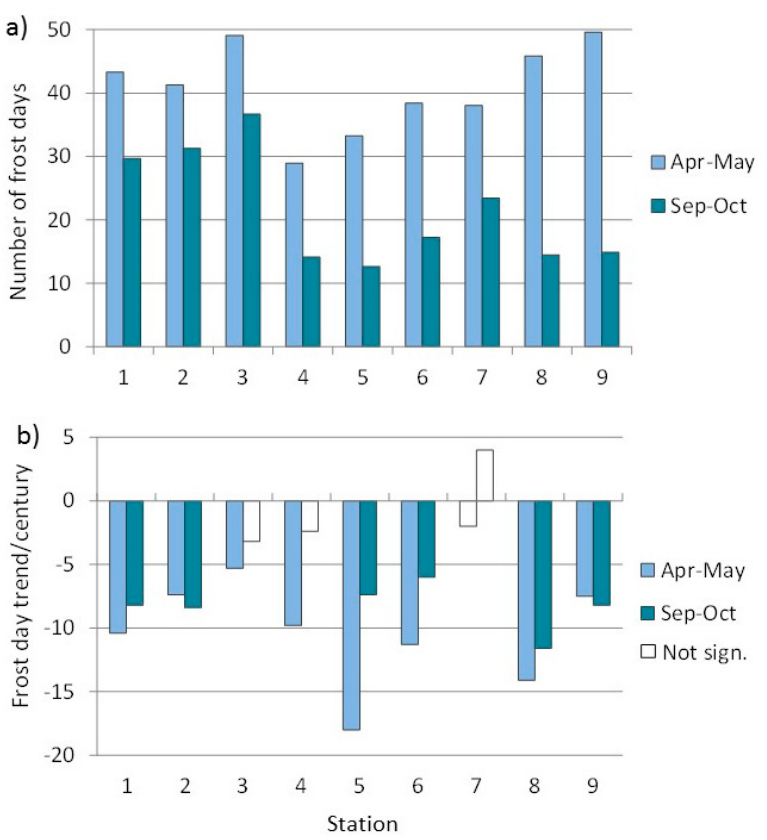
Figure 2. (a) The average number of frost days (TMin < 0°C) and ( b ) a frost day trend (change in the number of frost days/100 years) in April-May and September-October in nine studied weather station. Stations 1, 6, and 9 are homogeneous, and only isolated inhomogeneities were detected in stations 2 and 4.